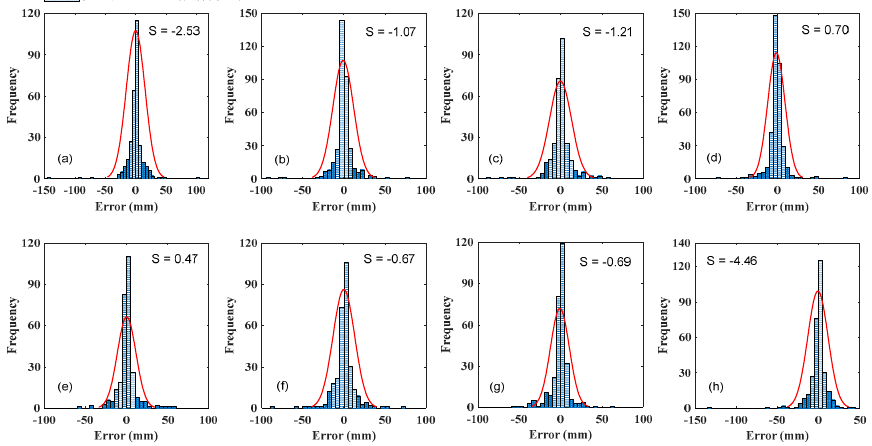
Figure 10. The histogram of daily rainfall error distribution for 3B42V7.